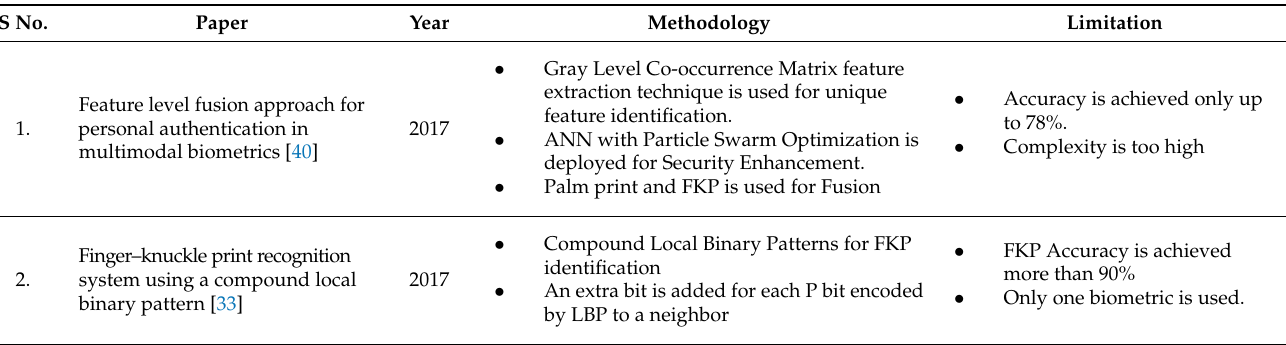
Table 1. Comparative analysis of different